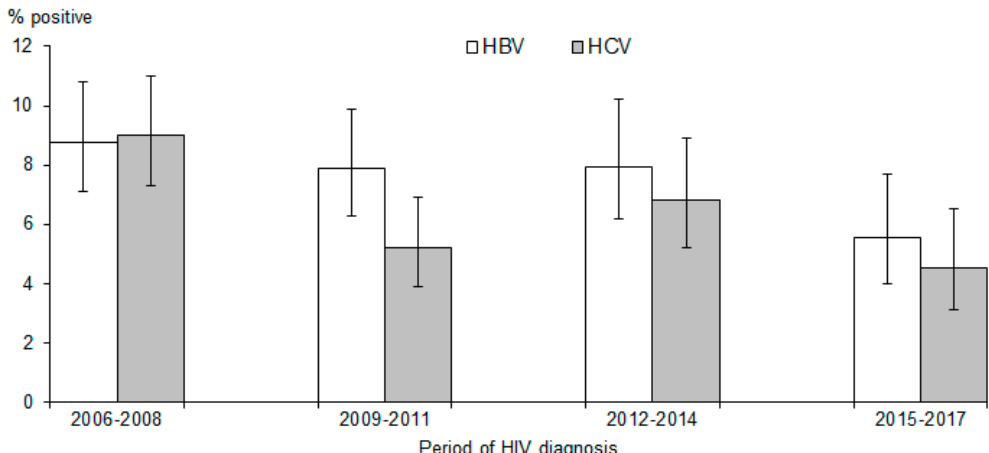
Figure 1. Proportions of HIV-infected patients tested positive for HBV and HCV by period of HIV diagnosis. The vertical lines indicate 95% confidence intervals.